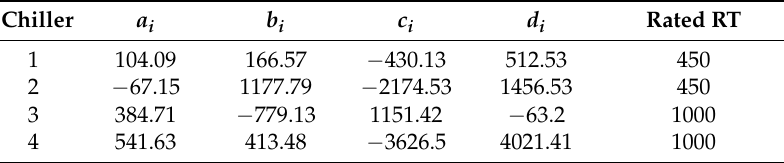
Table 4. Case study 2: Power consumption coefficient and rated RT